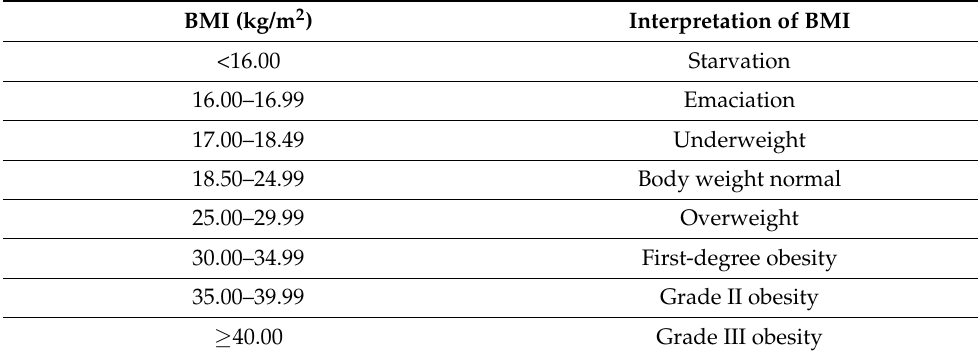
Table 1. BMI classification for adults